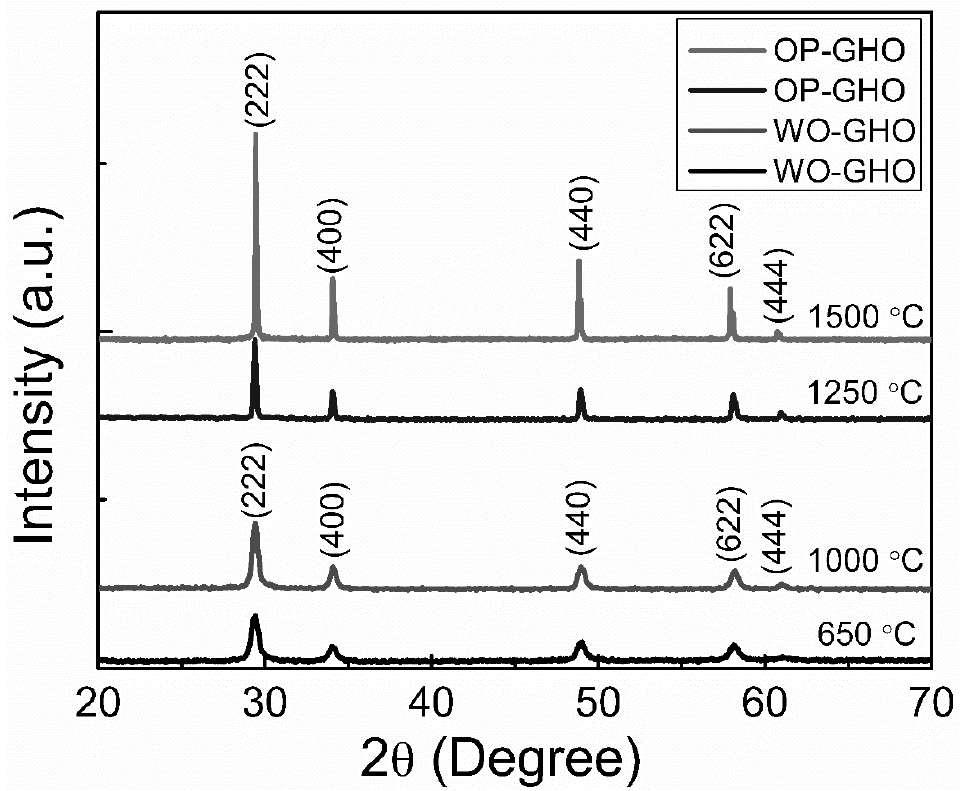
ff erent temperatures for 6